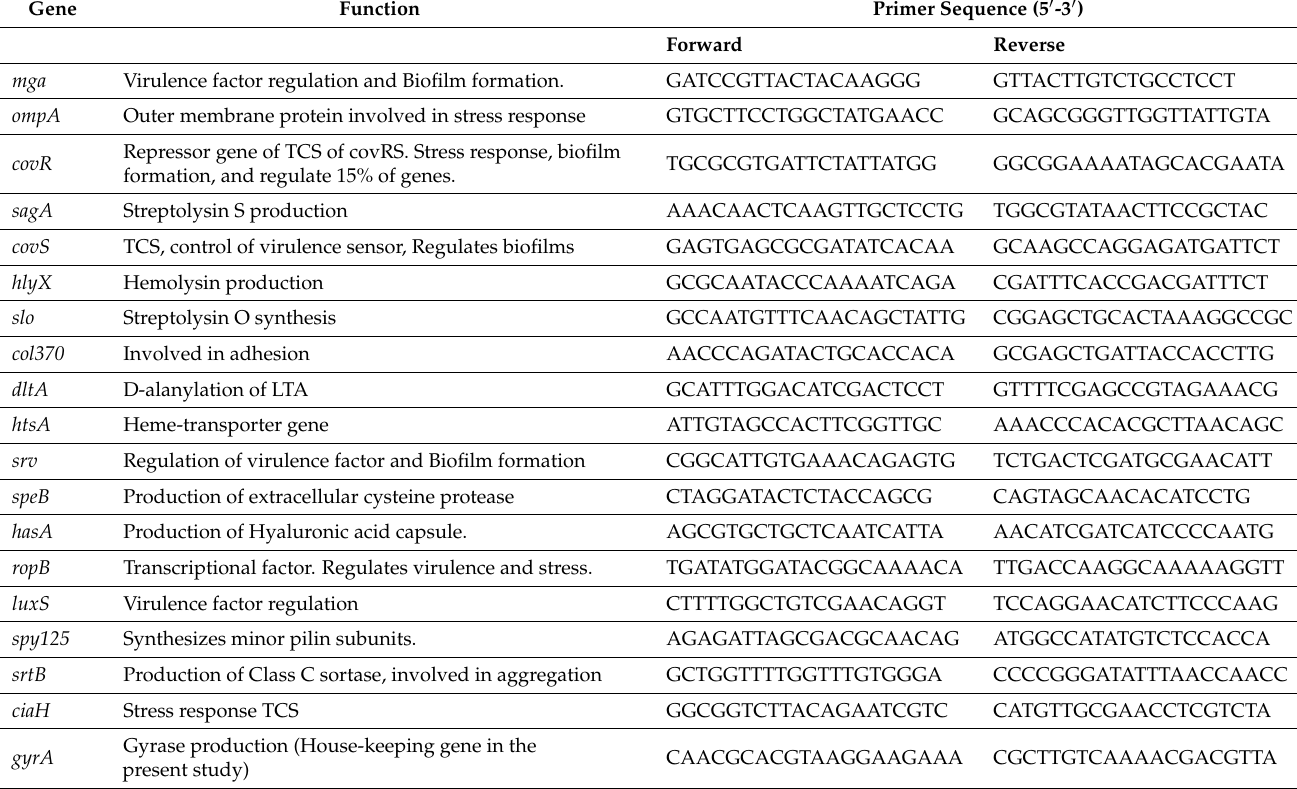
Table 2. List of genes used for real-time PCR analysis, with their functions and primer sequences